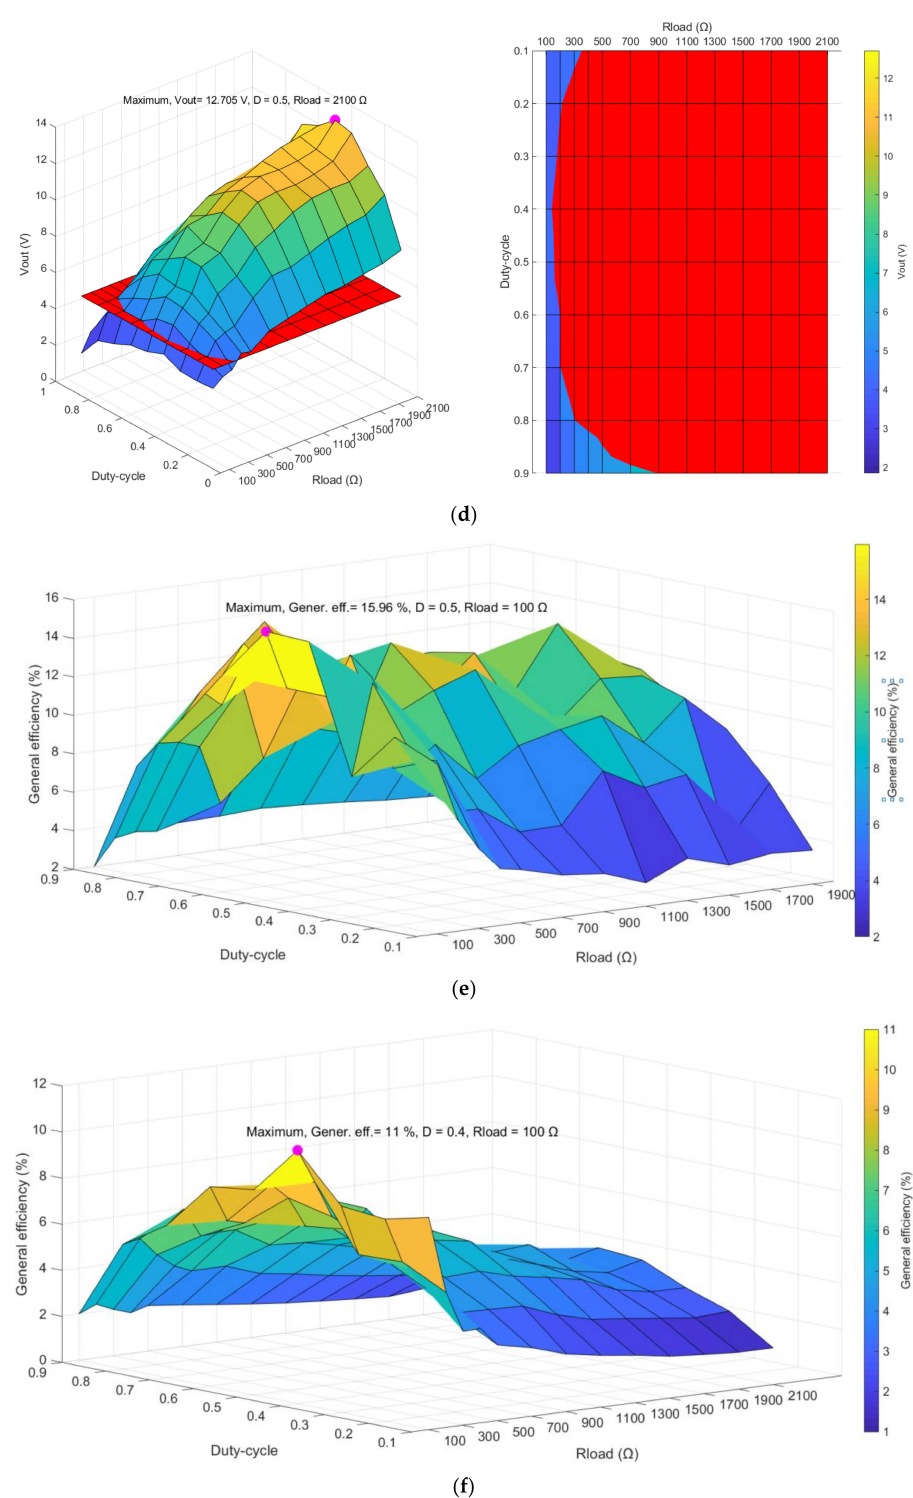
Figure 34. Split NP converter simulation results. The ( a , c , e ) figures are with 3 m / s wind velocity and 200 kHz switching frequency. The ( b , d , f ) figures are with 10 m / s wind velocity and 500 kHz switching frequency. ( a ) Output power (3 m / s, 200 kHz). ( b ) Output power (10 m / s; 500 kHz). ( c ) Output voltage (3 m / s, 200 kHz), Red plane: 3 V as minimum. ( d ) Output voltage (10 m / s, 500 kHz), Red plane: 3 V as minimum. ( e ) Generator + Converter e ffi ciency (3 m / s, 200 kHz). ( f ) Generator + Converter e ffi ciency (10 m / s; 500